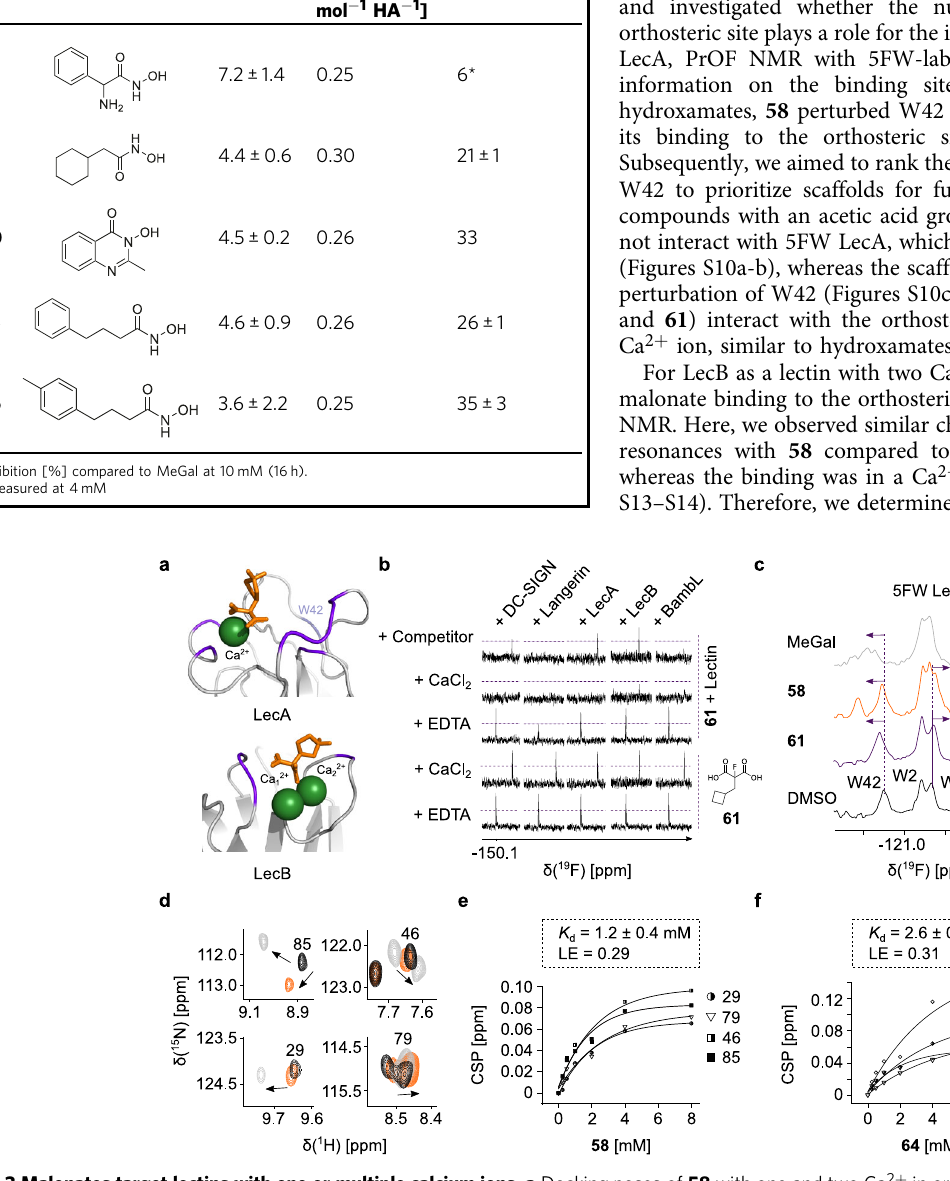
Fig. 3 Malonates target lectins with one or multiple calcium ions. a Docking poses of 58 with one and two Ca 2 + in or near the carbohydrate-binding site of LecA and LecB (PDB: 4CP9, 1OXC). The residues proposed to interact with lectins were highlighted ( violet ). b 19 F T 2 - fi ltered NMR using the analog of 58 ( 61 ) was used to assess the Ca 2 + -dependency and selectivity of the malonate-lectin interaction, where 61 bound to 10 mM CaCl 2 given a perturbation of fl uorine resonance. All lectins interacted with 61 in a Ca 2 + -dependent manner. The presence of competitors: 10 mM MeGal (LecA), 10 mM MeFuc (LecB/ BambL) and 30 mM D-mannose (DC-SIGN/Langerin) displaced 61 in LecA, LecB and DC-SIGN ECD verifying that malonates target the carbohydrate- binding site. c Shown is PrOF NMR of 0.15 mM 5FW LecA bound to 2 mM 58 or 61 as evident by CSPs of W42 and W33 ( arrow ). DMSO and MeGal served as negative and positive controls, respectively. ( d ) Examples of 15 N LecB residues in TROSY NMR alone ( black ) and with 2 mM 58 ( orange ) or MeFuc ( gray ). 58 perturbed the resonances 85, 46, 29 and 79 similarly to MeFuc. e and f One-site binding model was applied to derive the K d values of 58 and 64 by following CSPs of the resonances perturbed similar to